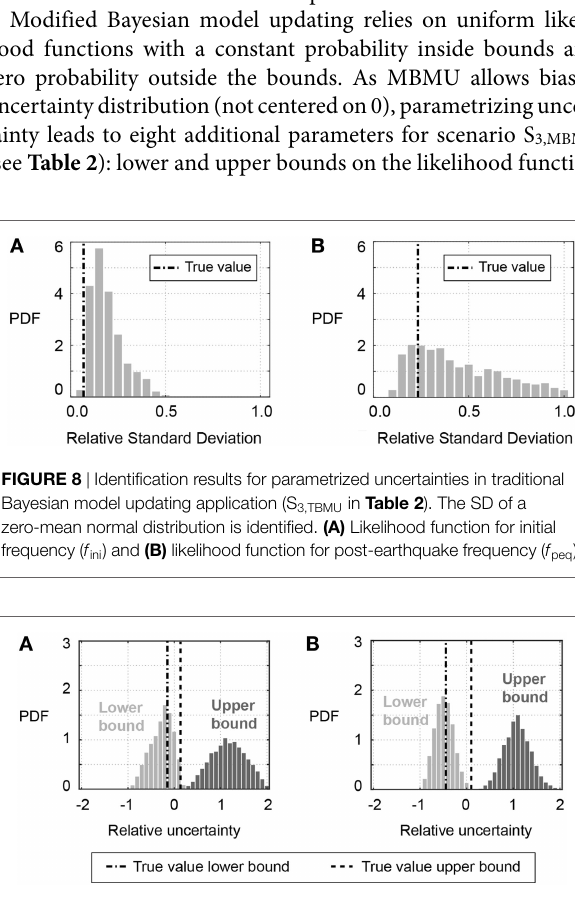
Frontiers in Built Environment |